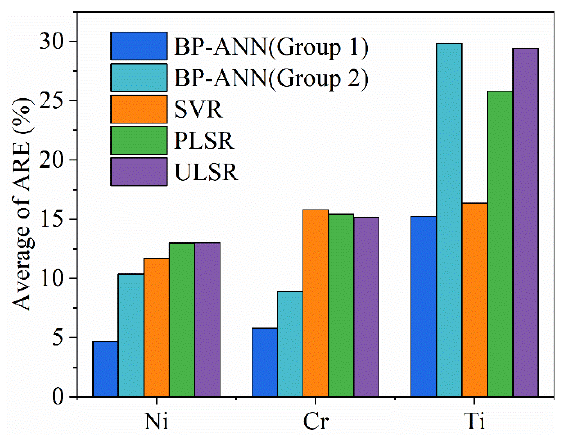
Figure 8. Comparison of different quantitative methods: the average of ARE of predicted results by BP-ANN, SVR, PLSR, and ULSR.